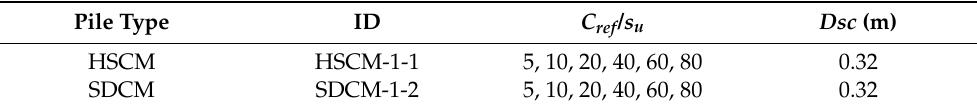
Table 3. Numerical simulation schemes .